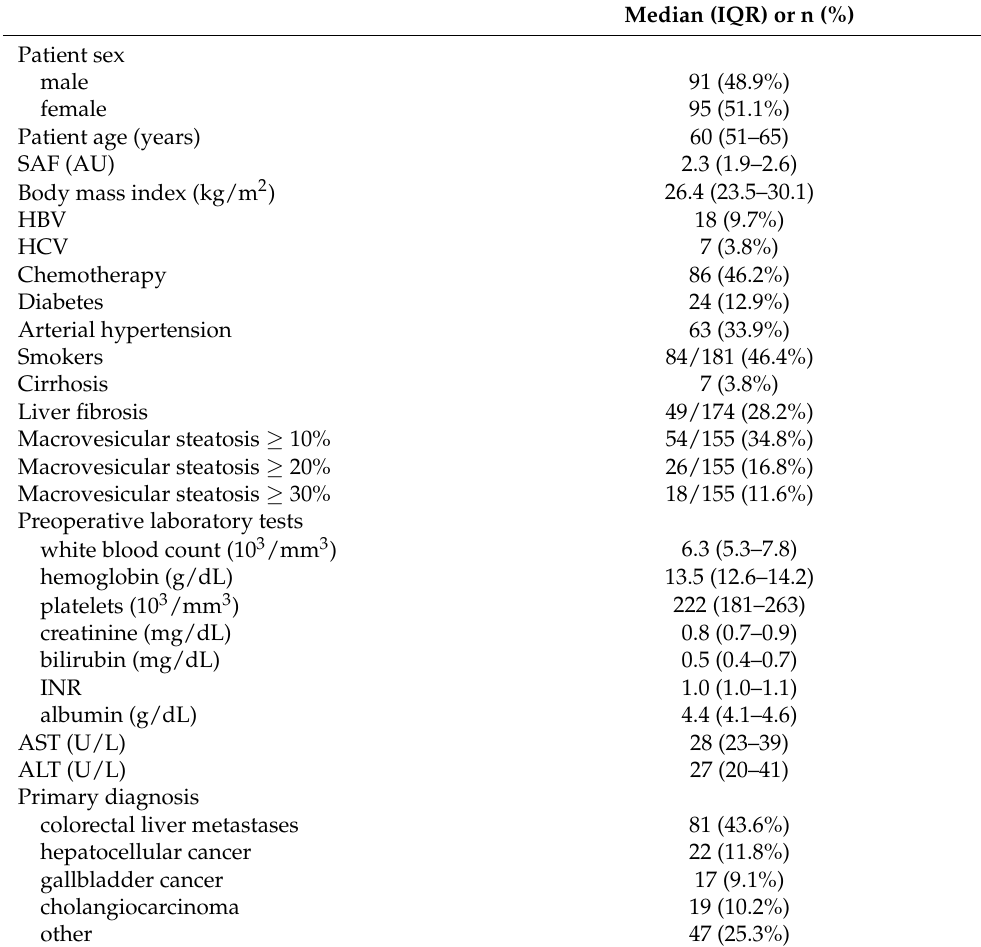
Table 1. Baseline